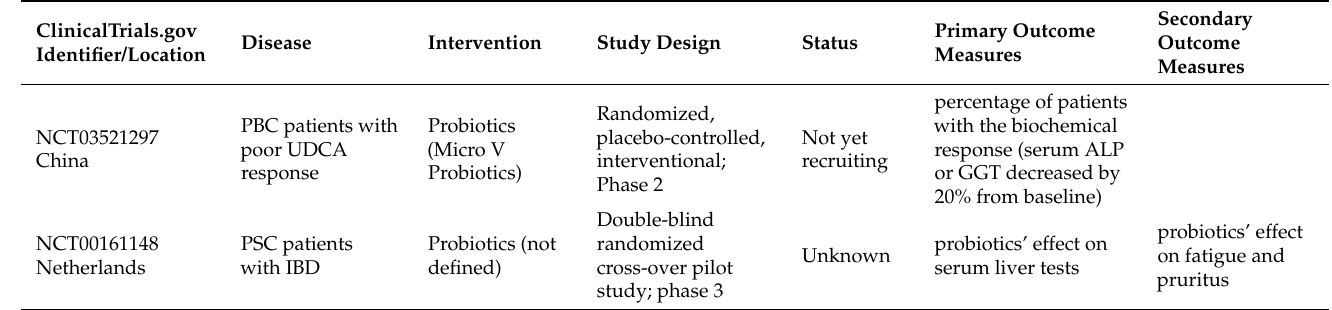
Table 3. Registered clinical trials of probiotic investigation in immune-related cholangiopathies (accessed through the website https://clinicaltrials.gov/ on 7 January